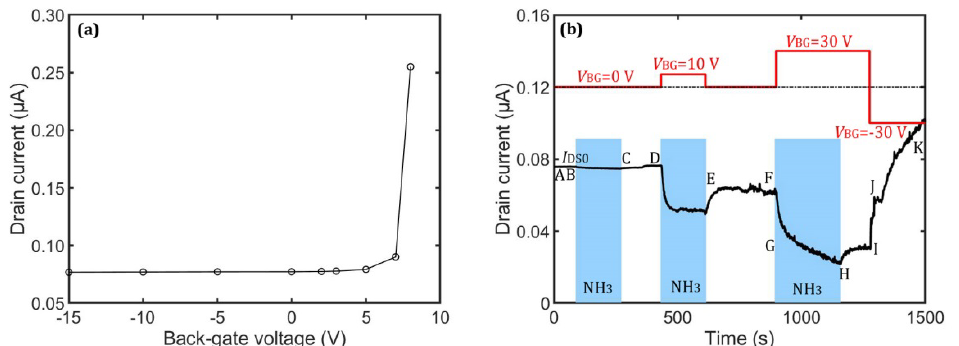
Figure 4. ( a ) The drain current/back-gate voltage characteristics for a fabricated PPy/G FET sensor in absence of NH 3 , confirming that this sensor is a typical accumulation-mode p -channel transistor. ( b ) The drain current ( I DS ) response of the PPy/G FET sensor to 1 ppm NH 3 under different back- gate voltages ( V BG ), experimentally showing that a positive back-gate voltage increases the sensor response and a negative back-gate voltage speeds up the sensor recovery. The blue rectangles indicate the NH 3 -on states and the red line notes the values and polarities of the back-gate voltages. As discussed above, the redox reaction of PPy with NH 3 plays an important